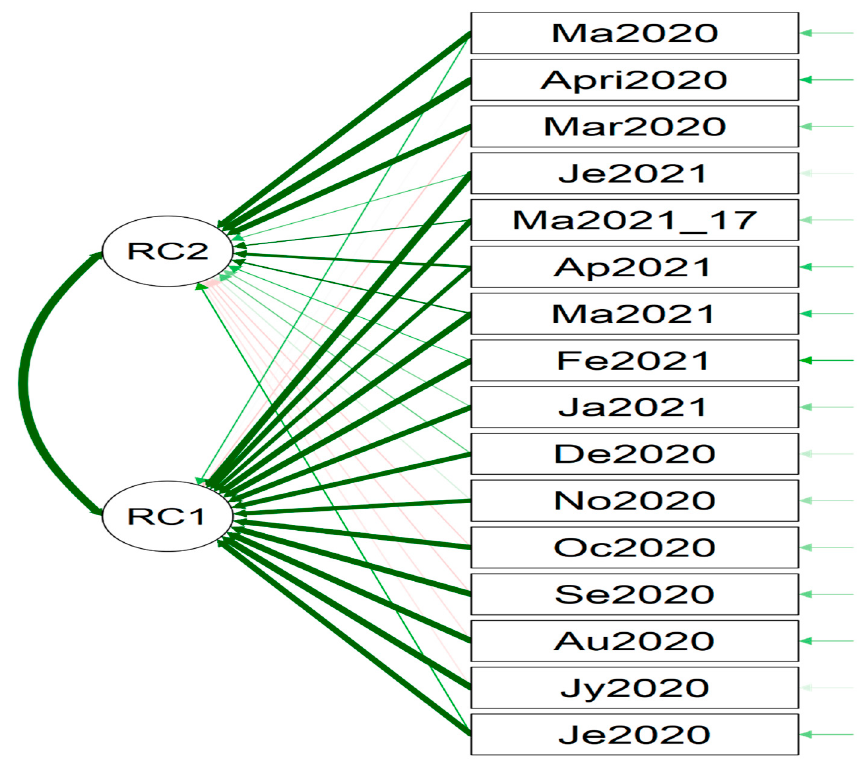
Figure 4. Proximity of the months (June 2020 through June 2021 as Cluster 1 and March, April, May 2020 as Cluster 2) with 81% of total variation explained by two principal components.